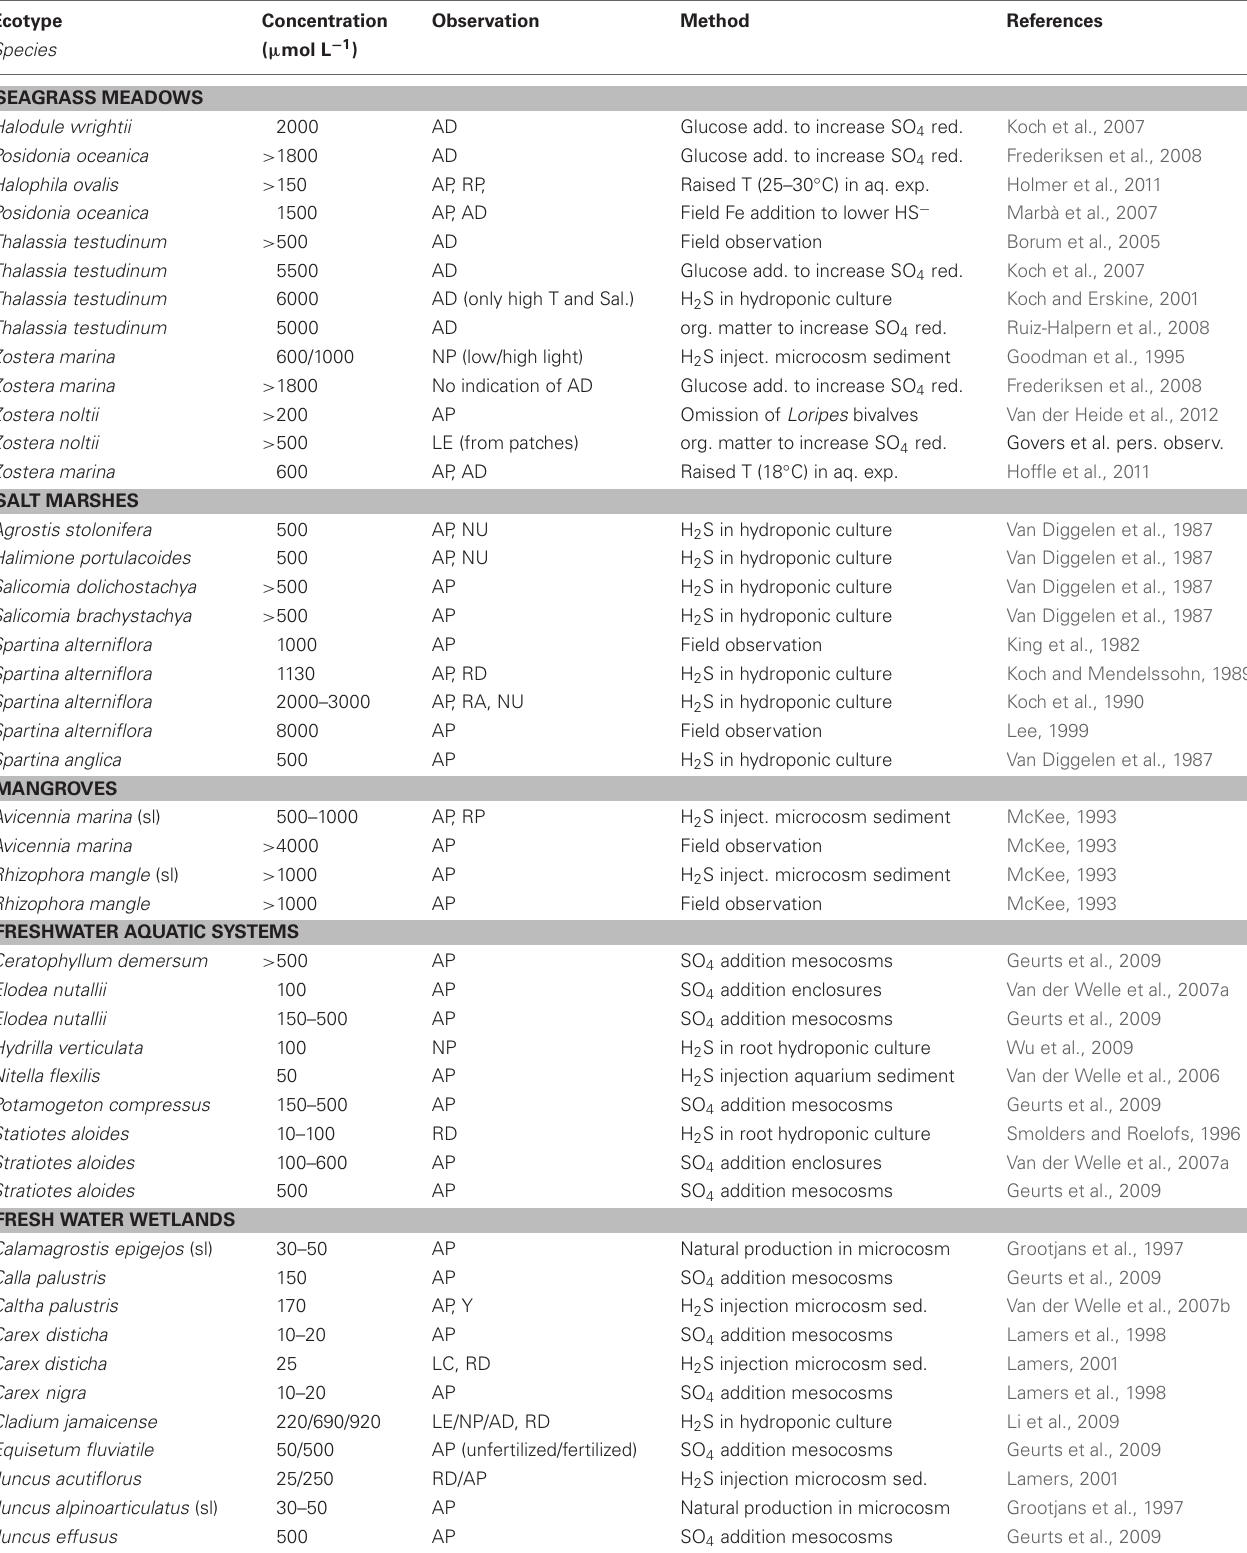
Table 1 | Overview of sulfide toxicity effects reported in marine, brackish and freshwater plants.